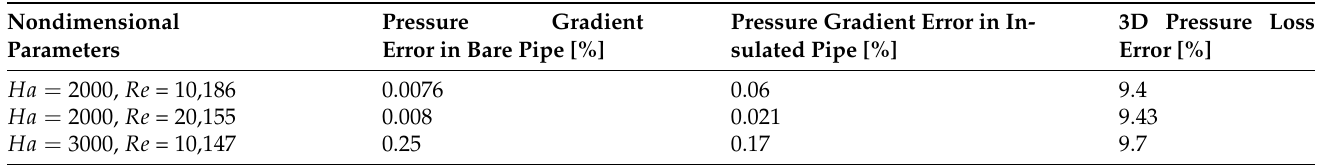
Figure 6. Total nondimensional pressure drop versus scaled axial length. Vertical dashed line states the beginning of the insulated part of the conduit. The deviation, between fully developed flow theory and numerical/experimental outcomes, that exists after x = 0 is due to three-dimensional pressure drop. Table 5. Relative errors of numerical results compared with theory/experimental